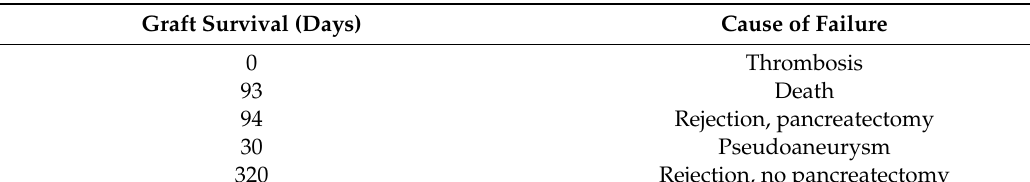
Table 2. Graft failures and cause after pancreas transplantation.